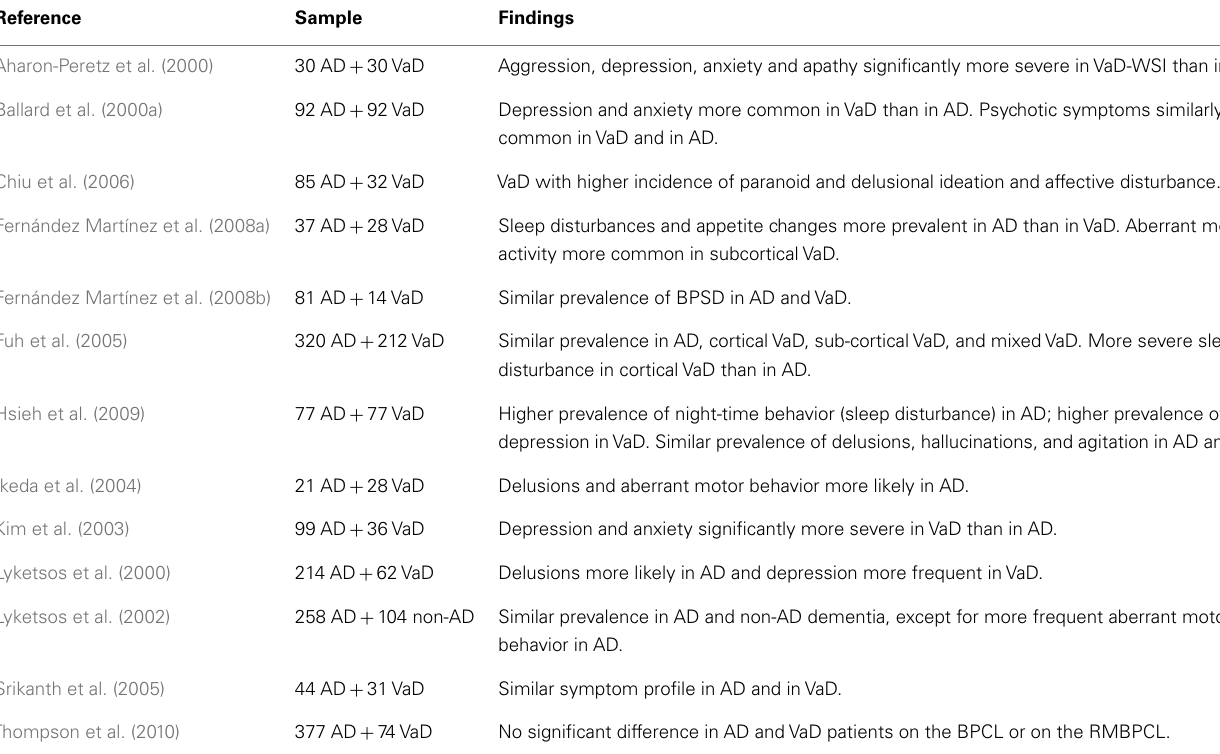
Table 4 | BPSD:Alzheimer’s disease vs. vascular dementia.